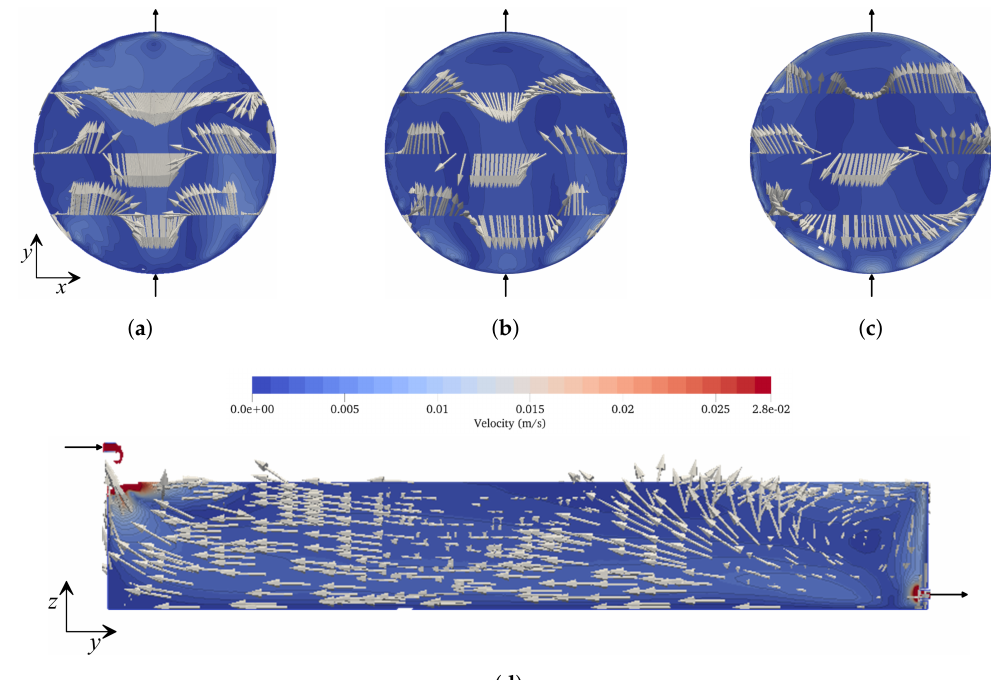
Figure 8. Plunging jet: velocity vectors and contours at 200 s in the horizontal plane at ( a ) z = 0.25 H ; ( b ) z = 0.5 H ; ( c ) z = 0.75 H ; and in the vertical plane at ( d ) y = 0.5 D T